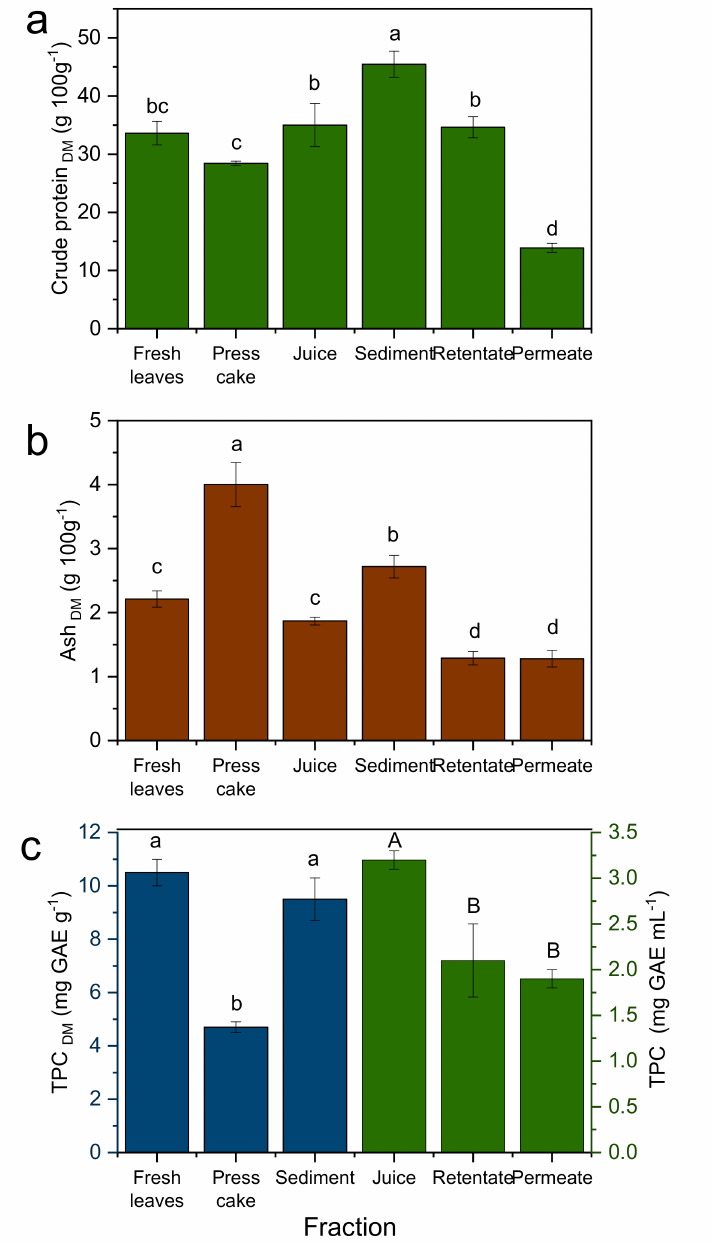
Figure 3. Nutritional content of cassava leaf processing fractions. ( a ) Crude protein CP n , ( b ) ash, and ( c ) total phenolic content (TPC). Means marked by different letters are statistically different ( n = 3; Tukey test, p ≤